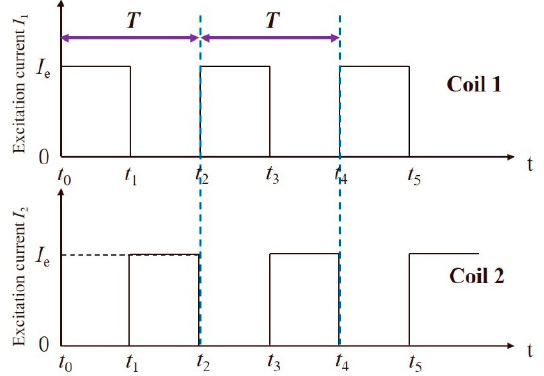
Figure 2. Waveform of the excitation current.